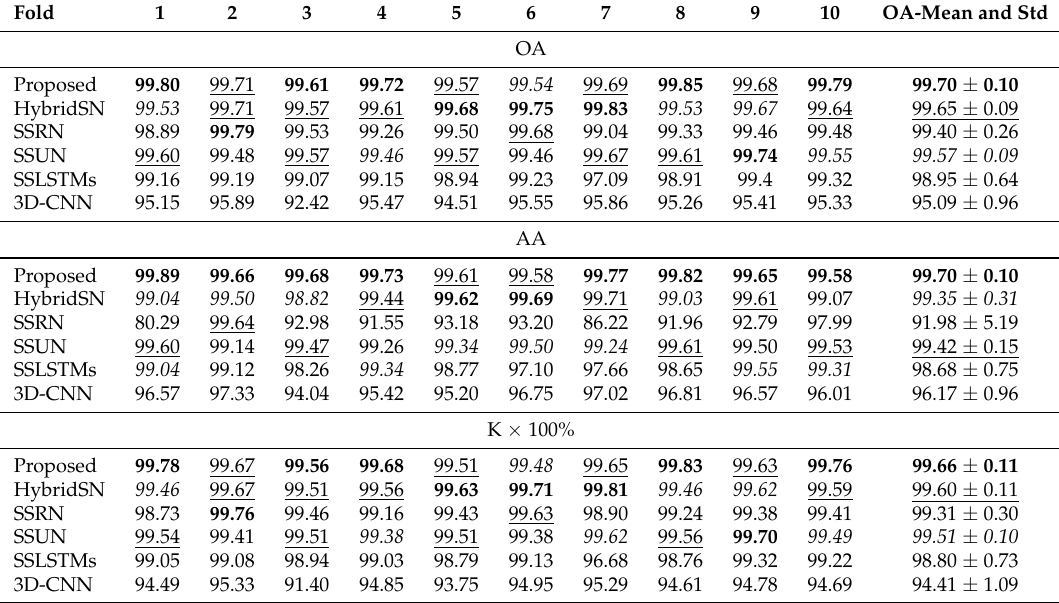
Table 9. Fold Overall Accuracy, Average Accuracy, and Kappa Value on IP dataset with 30% training data. The best performance is in bold, the second-best performance is underlined, and the third-best is in